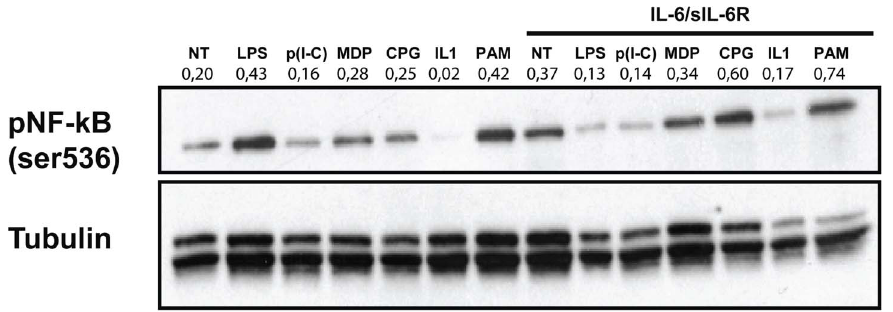
Figure 4. Increased p65 NF- k B activation in response to inflammatory stimuli in human PBMCs pre-exposed to IL-6/IL-6R. Western blots showing the expression of phospho–p65 NF-kB (Ser 536 ) in total lysates from human PBMCs pre-exposed to IL-6 (10 ng/ml) in combination with sIL-6R (125 ng/ml) for 1 hour and stimulated with LPS, poly(I-C), MDP, CpG, IL-1 b , PAM (used at the same concentrations as in Figure 2) for 90 minutes. Expression of a -tubulin was used as a loading control. Results of densitometric analysis are shown above each blot. Data are representative of 3 independent experiments.